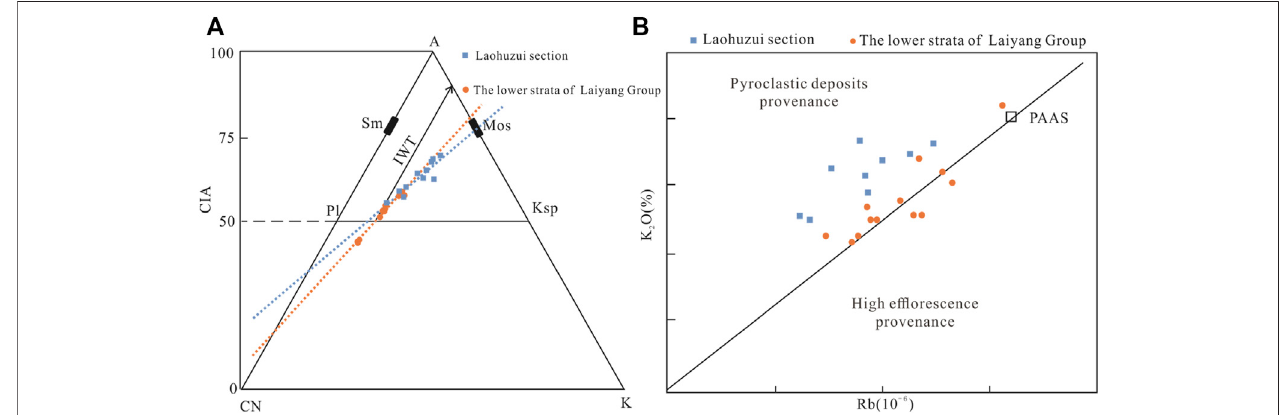
FIGURE 7 | Weathering degree discrimination diagram of the Laohuzui section and the lower strata of the Laiyang Group. (A) Al 2 O 3 -(CaO + Na 2 O)-K 2 O molecular proportion for siltstone, Sm: montmorillonite; Mos: illite; Pl: plagioclase; and Ksp: potassium feldspar, modi fi ed from Nesbitt and Young (1982). (B) K 2 O – Rb discrimination diagram for the provenance of siltstones, after Di Leo et al. (2002).